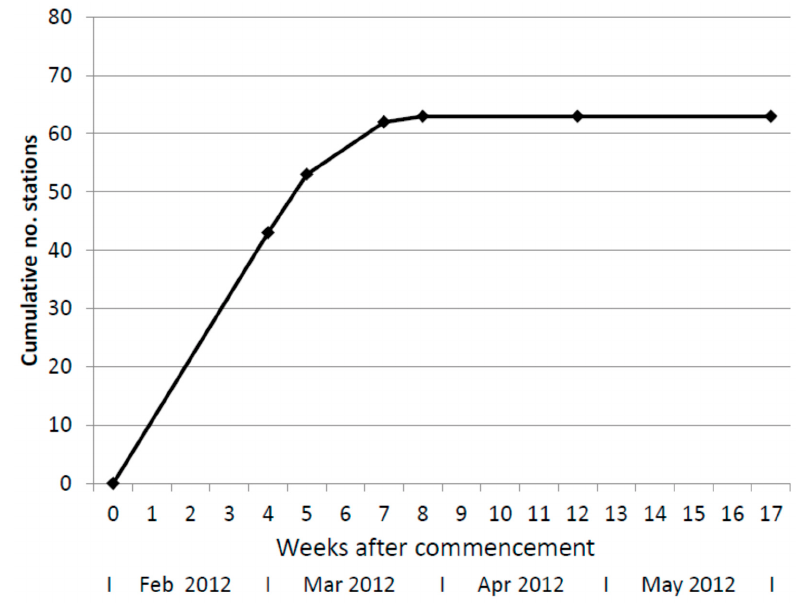
Figure 1. Cumulative number of in-ground bait stations infested with termites over